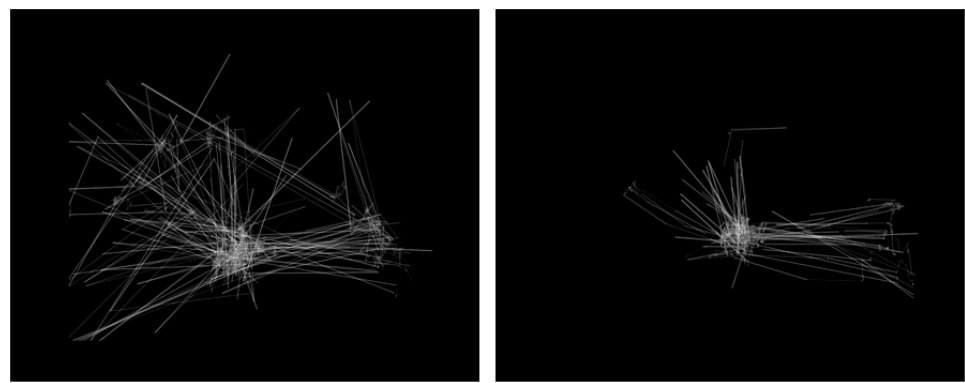
Figure 4. Visualization of eye-tracking scanpaths [52]. The left -sided image represents an autism spec- trum disorder (ASD) sample, while the right -sided image represents the typically developing